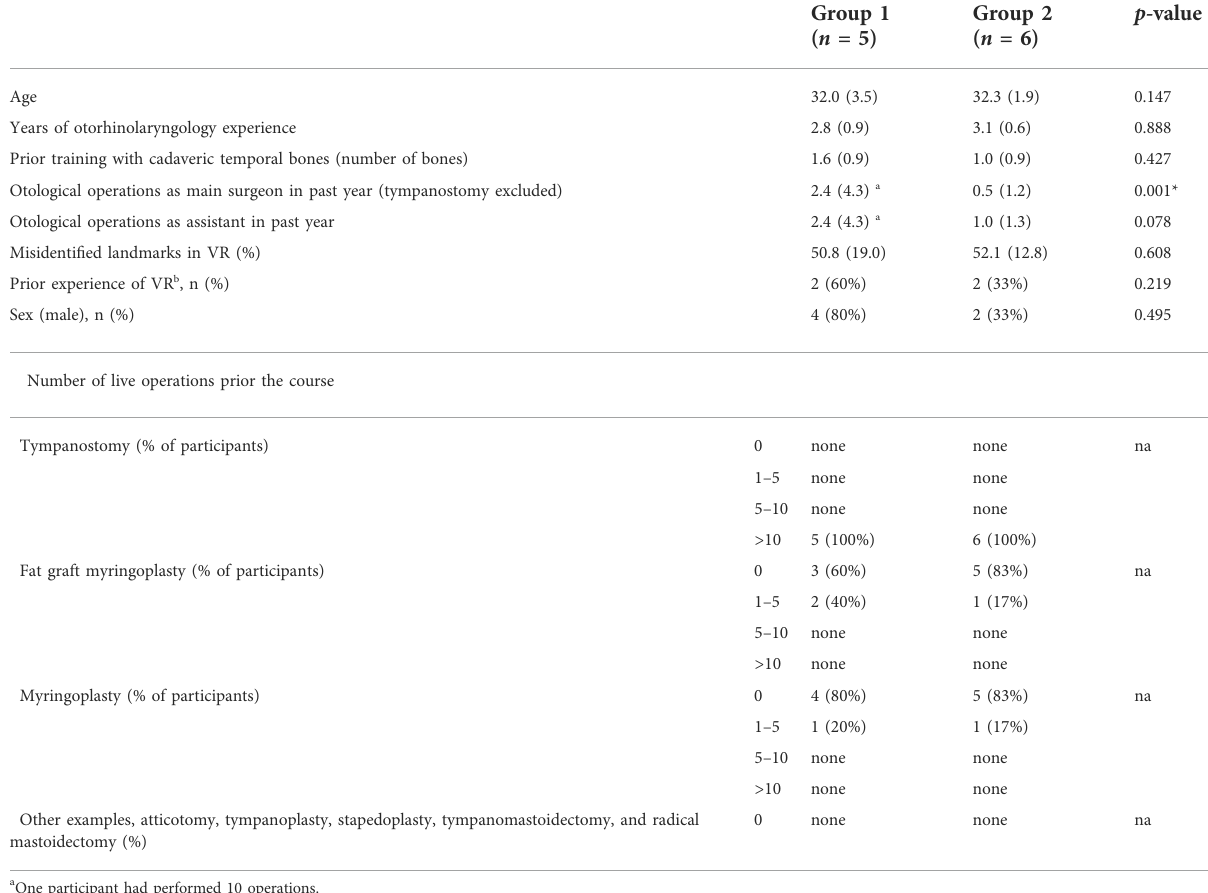
TABLE 1 Participant demographics and surgical experience. The values are mean (SD) unless otherwise